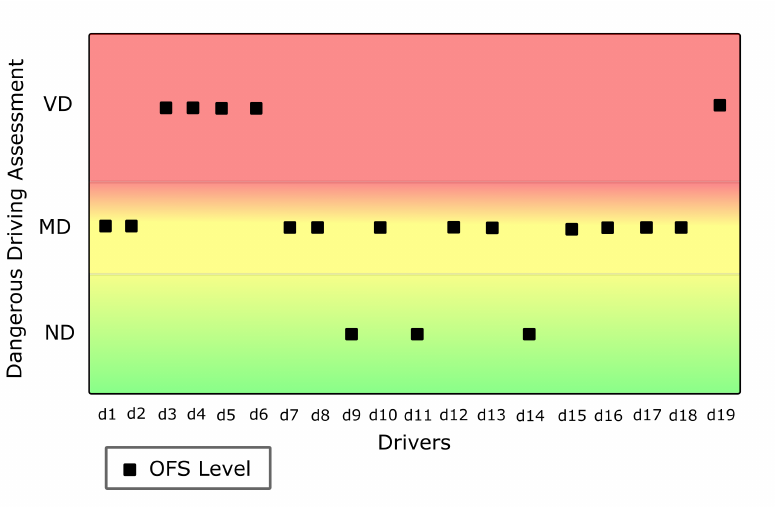
Figure 9. Objective Fuzzy System (OFS)